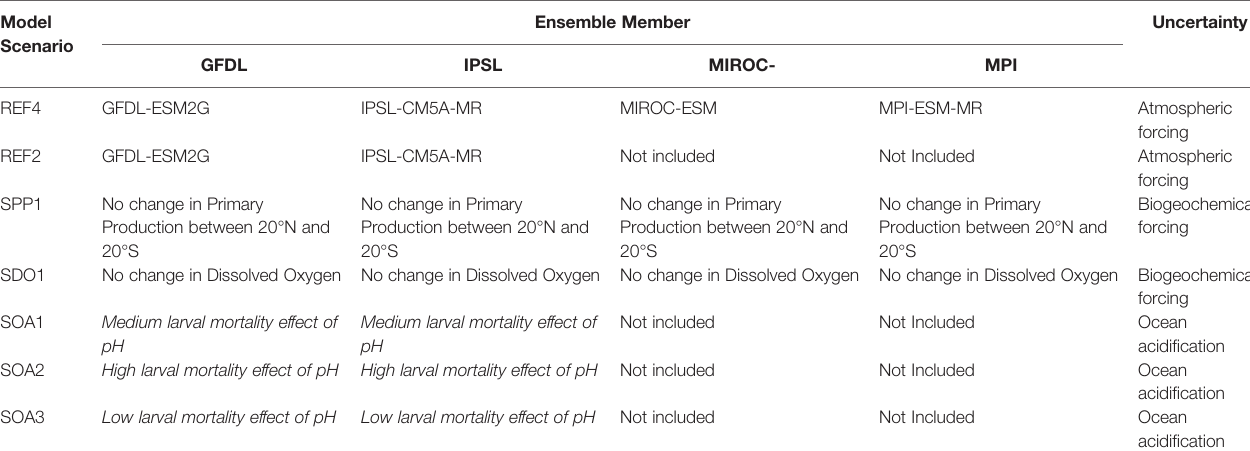
TABLE 1 | Description of the ensemble of 18 simulations used in this study. The last column provides a descriptor of the model uncertainty considered in each scenario. Model